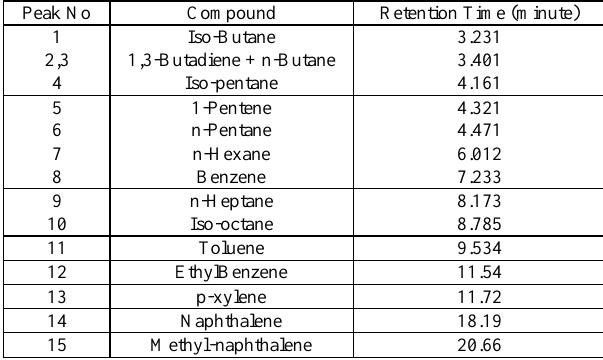
Table 5. Retention time of standard sample components